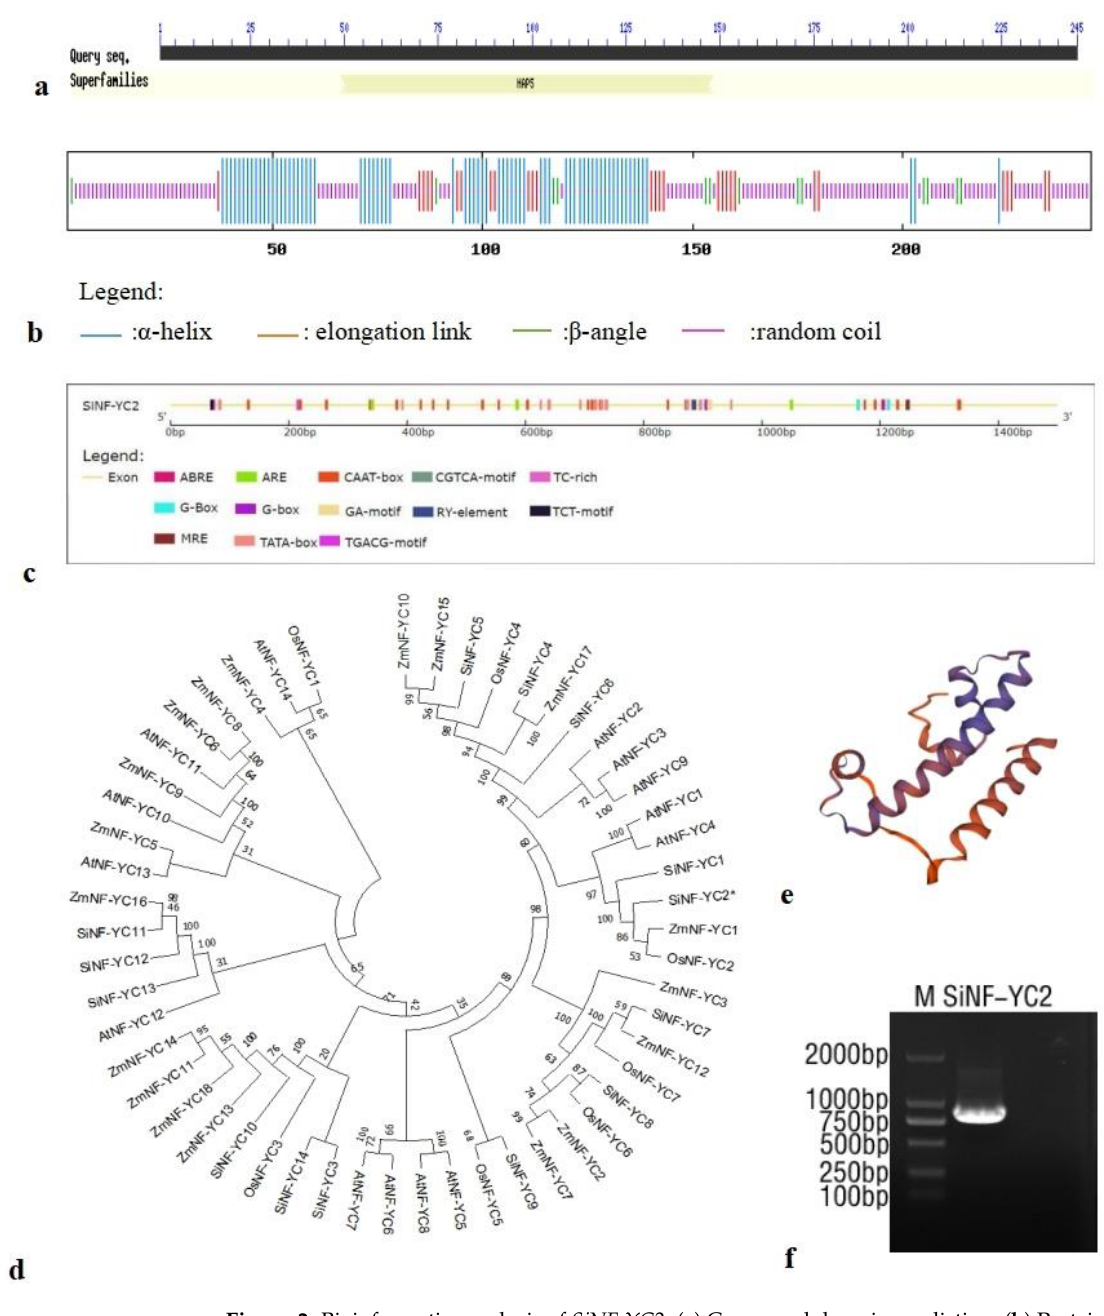
Figure 2. Bioinformatics analysis of SiNF-YC2 . ( a ) Conserved domain prediction. ( b ) Protein secondary structure analysis. ( c ) cis-Acting elements in SiNF-YC2 promoter. ( d ) Evolutionary analysis of SiNF-YC2 (At: Arabidopsis thaliana ; Zm: Zea mays ; Si: Setaria italica ; Os: Oryza sativa ). The asterisk indicates SiNF-YC2 . ( e ) Protein tertiary structure prediction. ( f ) Cloning of SiNF-YC2 (M: 2 kb DNA marker).